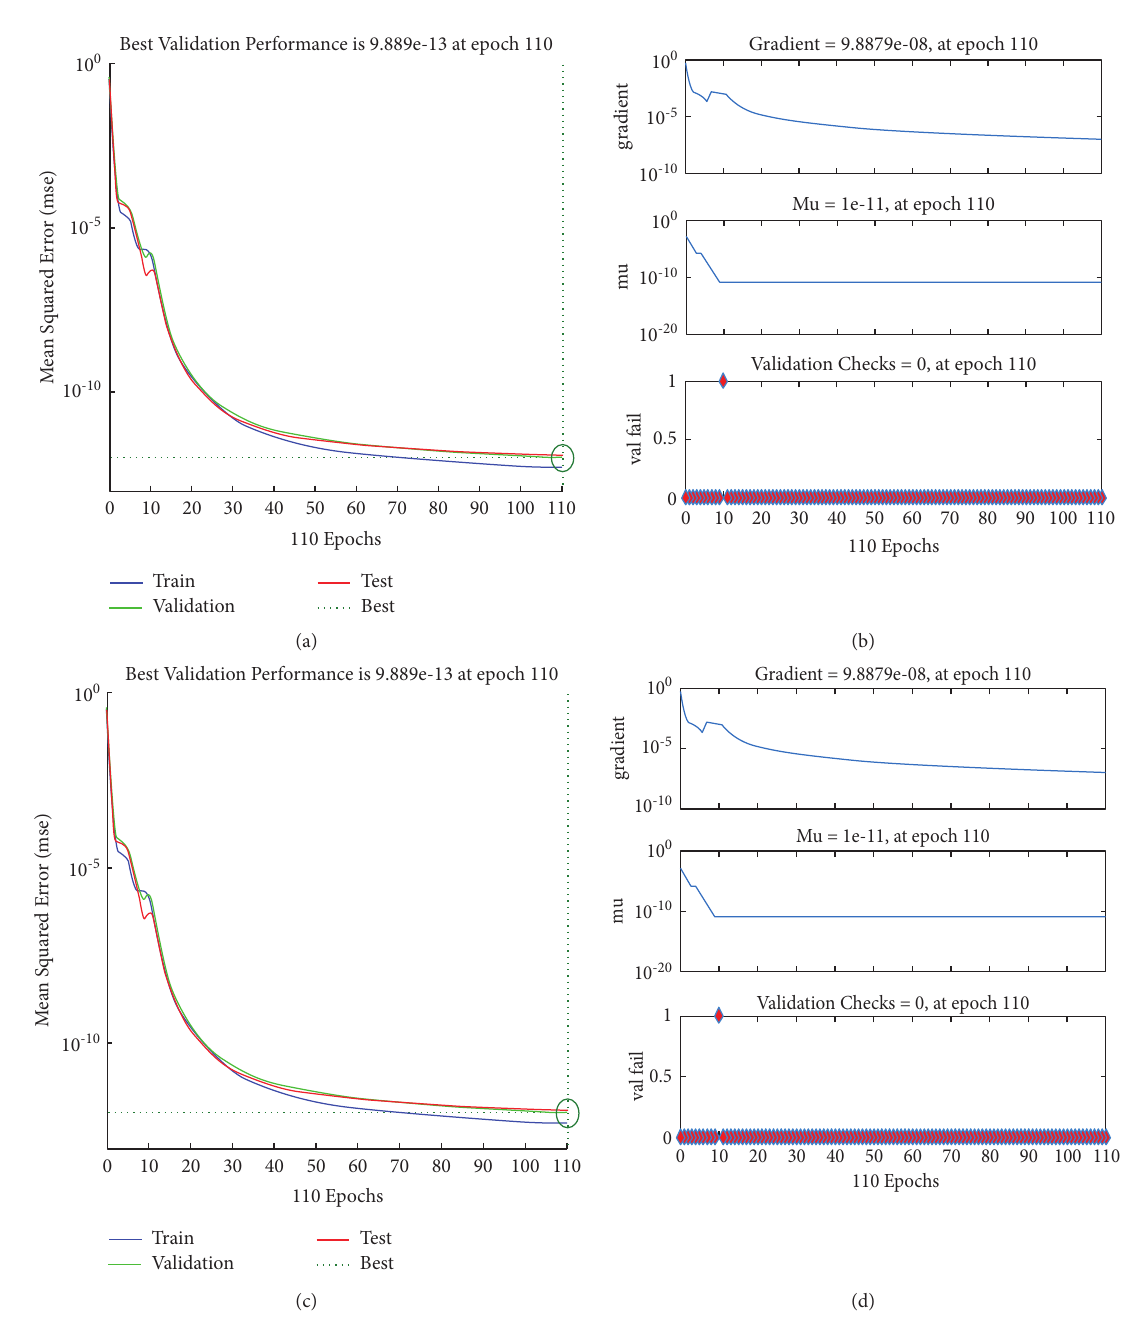
Figure 3: The performance and MSE outcomes of LMA-BANN in two cases of the MPFPCMI